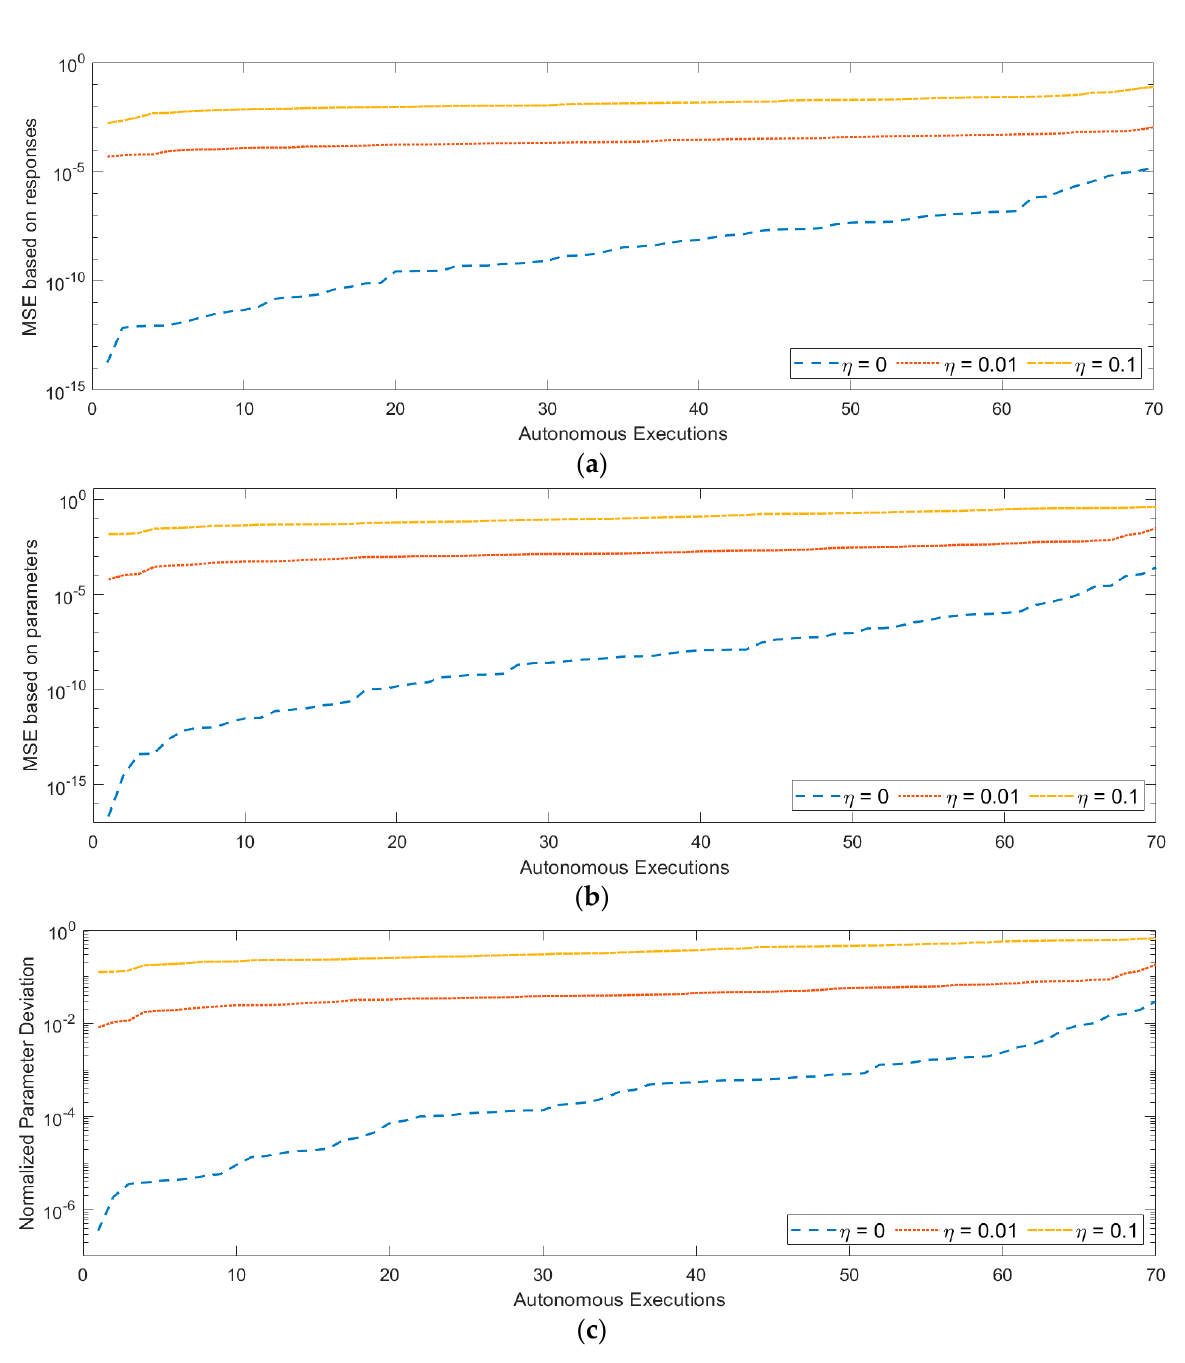
Figure 6. Results of autonomous executions through different evaluation metrics for Problem 1. ( a ) MSE through estimated response ( b ) MSE through estimated parameters ( c ) Normalized parame- ter deviation